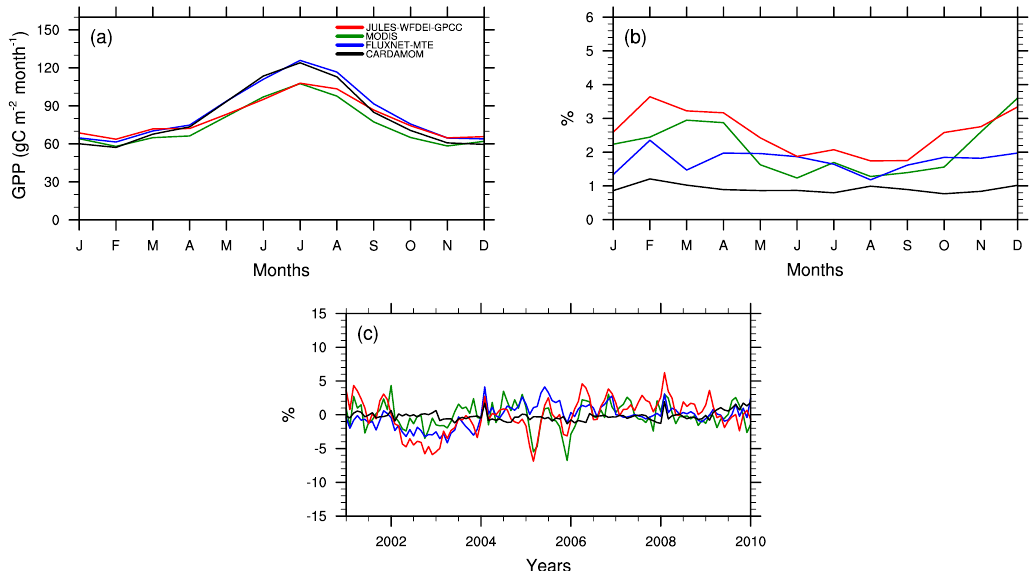
Figure 3. Comparison of JULES, observation-based (FLUXNET-MTE and MODIS) and CARDAMOM (Table 1) GPP fluxes for the 2001– 2010 period on global scales. Panel (a) shows the global average of the mean monthly GPP, (b) shows the coefficient of variation (CV) expressed as percentages of the mean monthly GPP and (c) shows the monthly anomalies expressed as percentages of the mean monthly GPP for each